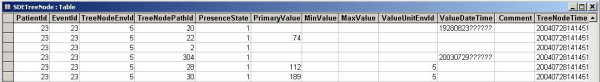
Screen capture of the table SDETreeNode in OpenSDE. The first row contains the column headers. The first three columns represent references to the patient, event (registration session) and the version of the domain tree. TreeNodePathId refers to the recorded node in the domain tree. The columns that include "val" are used to store values. ValueUnitEnvId refers to the unit of the value. Comment can store free-text. TreeNodeTime refers to the moment to which the observation applies.